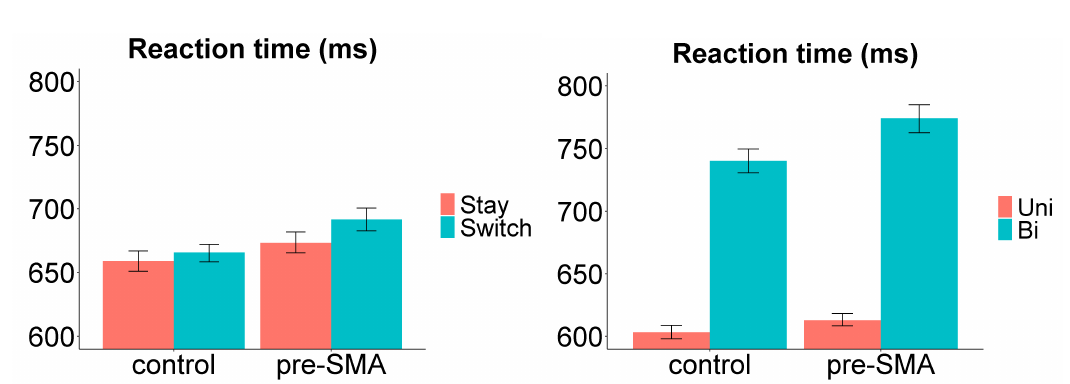
Figure 7. The effect of TMS stimulation on the switch cost and valence cost in Experiment 2. ( A ) Reaction time as a function of “TMS location” (control site vs. pre-SMA) and “transition type” (stay vs. switch trials). TMS did not significantly modulate the switch cost. ( B ) Reaction time as a function of “TMS location” (control site vs. pre-SMA) and “valence” (univalent vs. bivalent items). The valence cost was larger when TMS was applied on the pre-SMA (marginally significant interaction). Error bars indicate one standard error above and below the means. Uni = univalent items; Bi = bivalent items. There was no interaction between TMS location and transition type in the naming